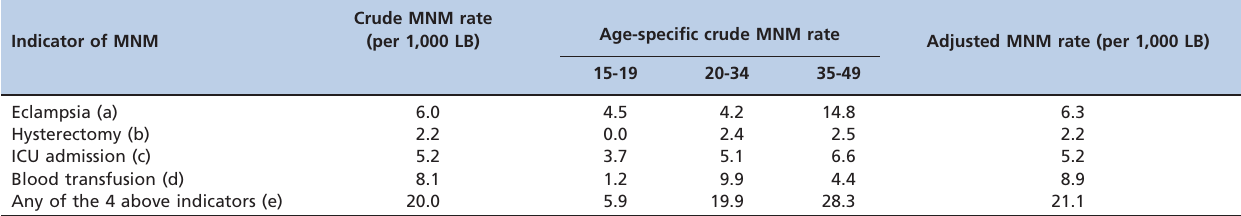
Table 3 - Crude, age-specific and adjusted rates of self-reported MNM *. DHS, Brazil, 2006. Indicator of MNM